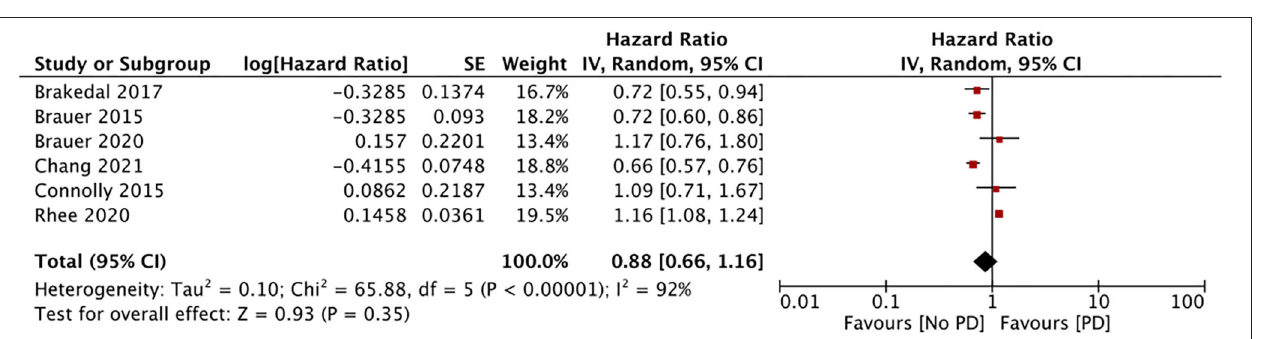
FIGURE 4 | Meta-analysis of PD risk in patients with DM using GTZ.